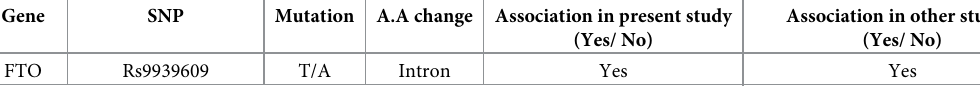
Table 4. Comparison of genotype associations with PCOS–current study versus. other reports.